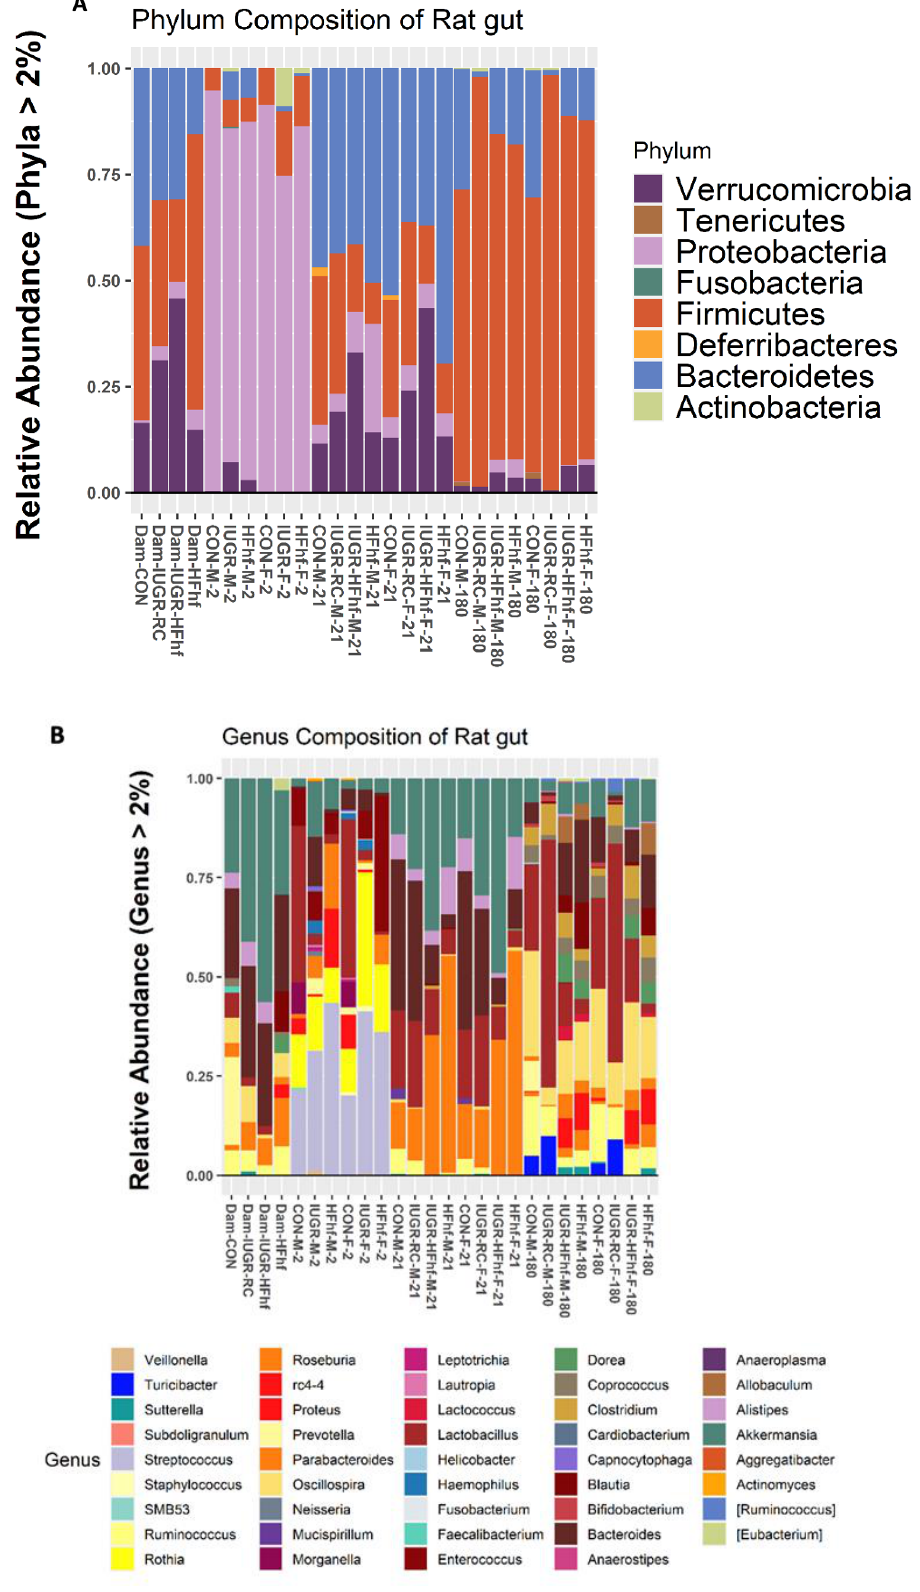
Figure 3. Taxonomic profiles of fecal microbiota by 16S rRNA gene sequencing at the Phylum ( A ) and Genus ( B ) levels .